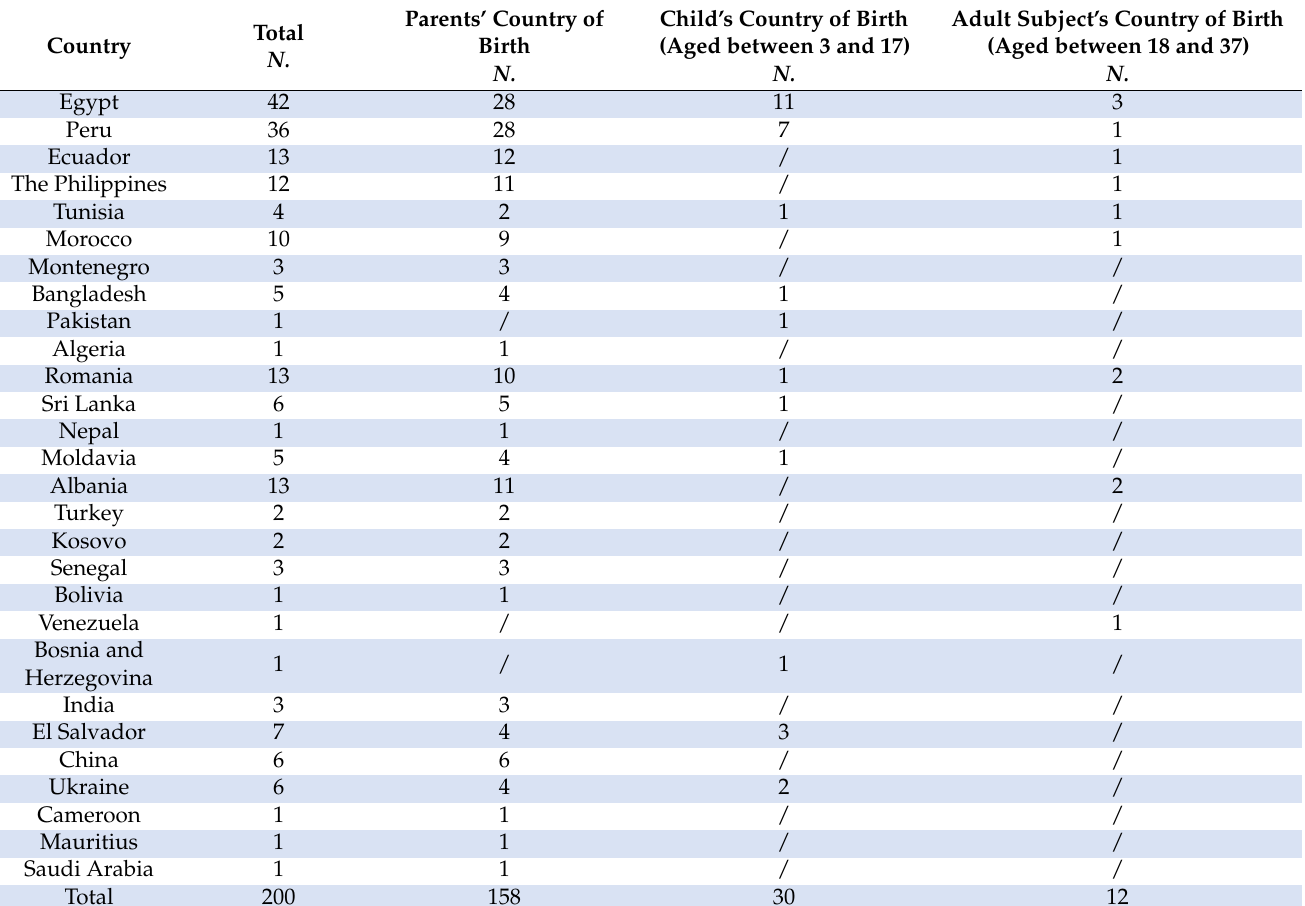
Table 1. Country of origin of included